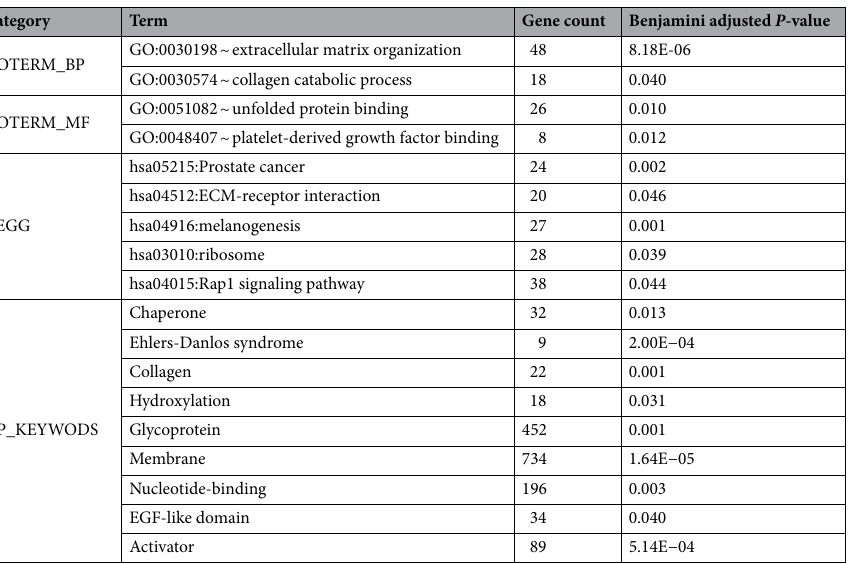
Table 2. DAVID functional clustering obtained considering the macro-module containing darkred, midnightblue, paleturquoise4 and red